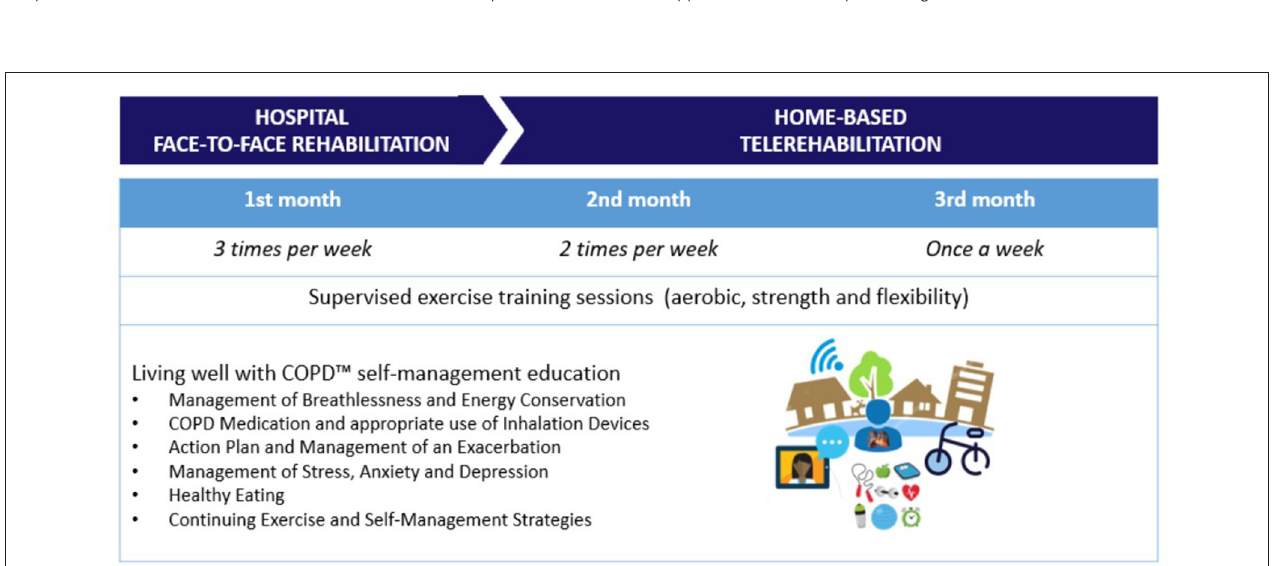
FIGURE 1 | From hospital face-to-face rehabilitation to home-based telerehabilitation.